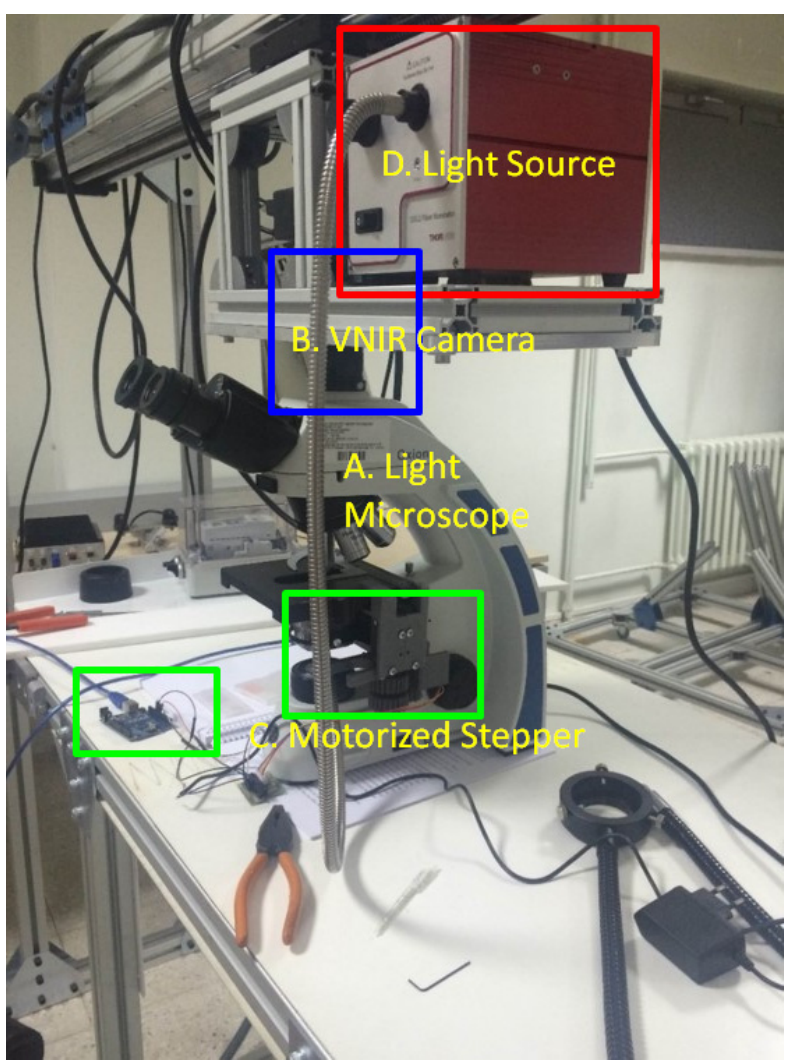
Figure 1. Data Acquisition system. A, Light microscope; B, VNIR Camera; C, Motorized Stepper; D, Light Source.